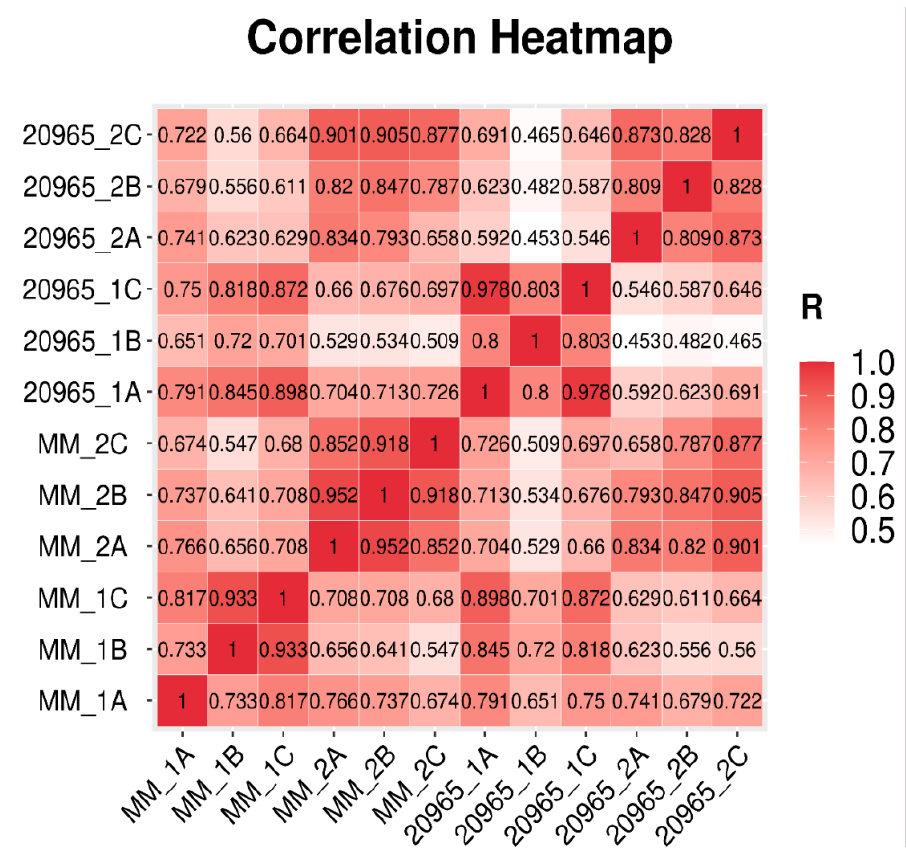
Figure 1. Pearson correlation coefficients of all 12 samples. The Pearson correlation coefficients of all gene expression levels between every two